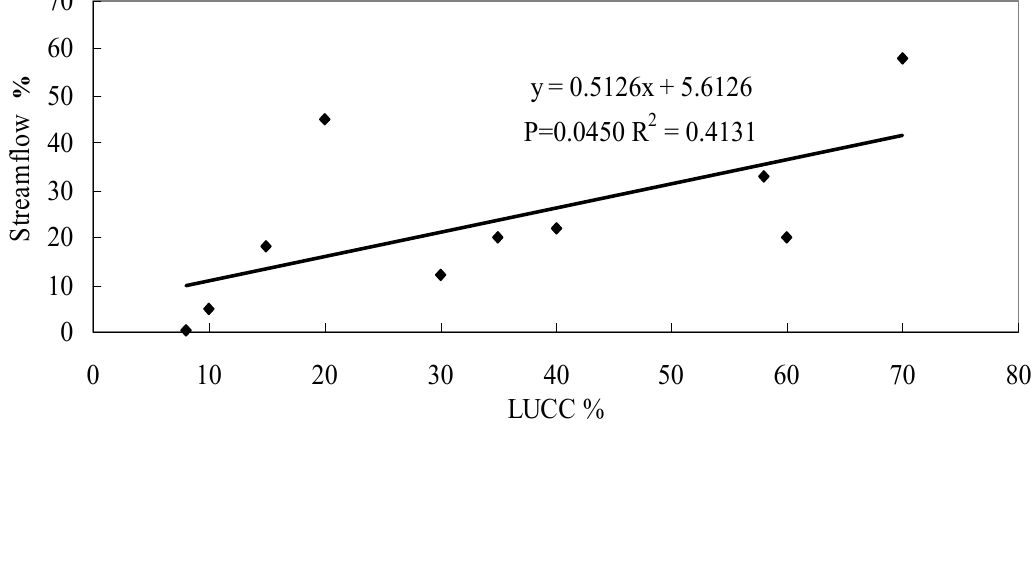
Figure 2. Relationship between forest or land cover changes (LUCC) and their relative contributions to